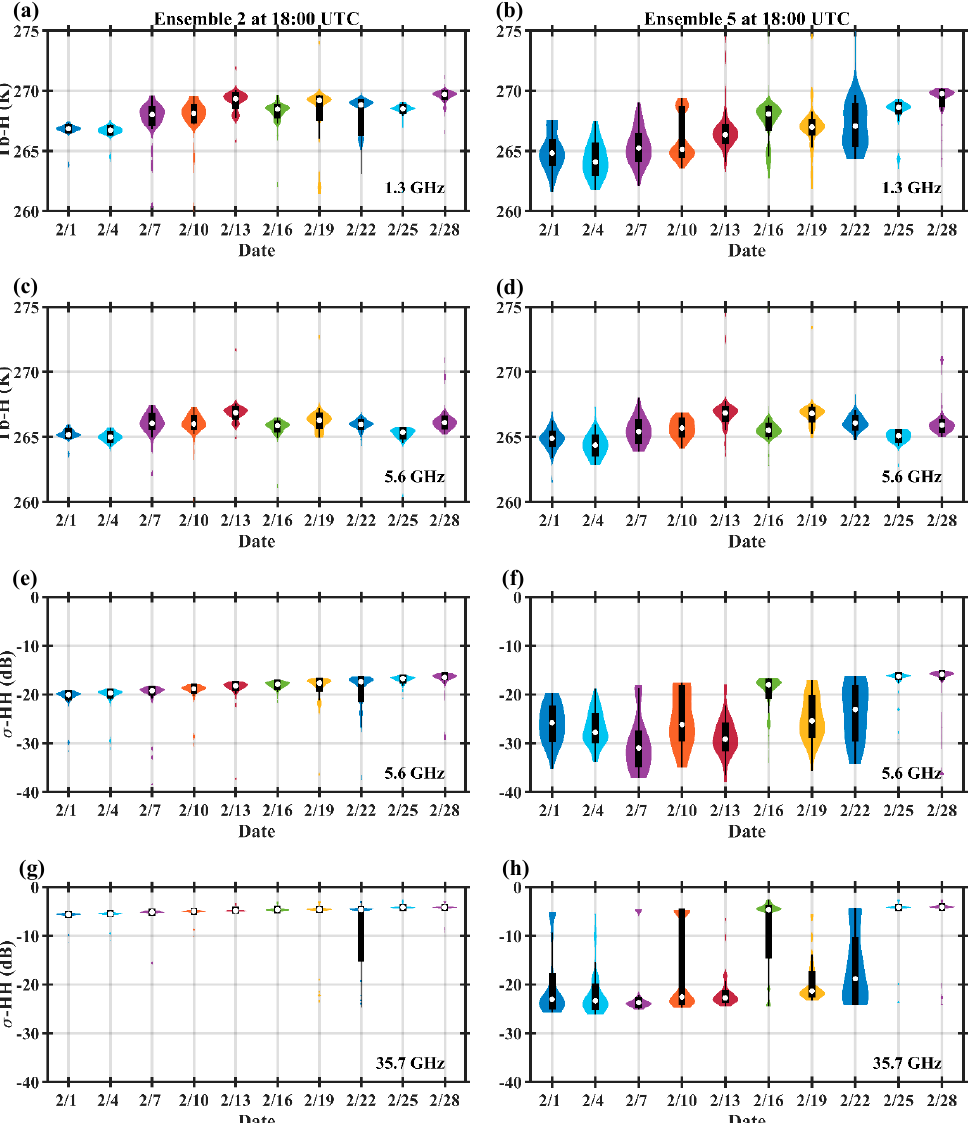
Figure 9. Spatial variability of H-pol brightness temperatures Tb ( a – d ) and backscattering coefficients for C- (5.6 GHz, e , f ) and Ka- (35.7 GHz, g , h ) bands at 18:00 UTC (1 PM MST) across the Grand Mesa from Ensemble 2 (left column) and Ensemble 5 (right column) during February 2017. For each violin diagram, the white dot represents the median; the vertical black bar demarks the 25th and 75th percentiles; the upper and lower bounds represent the maximum and minimum values respectively; and finally, the colored contour is the density distribution.